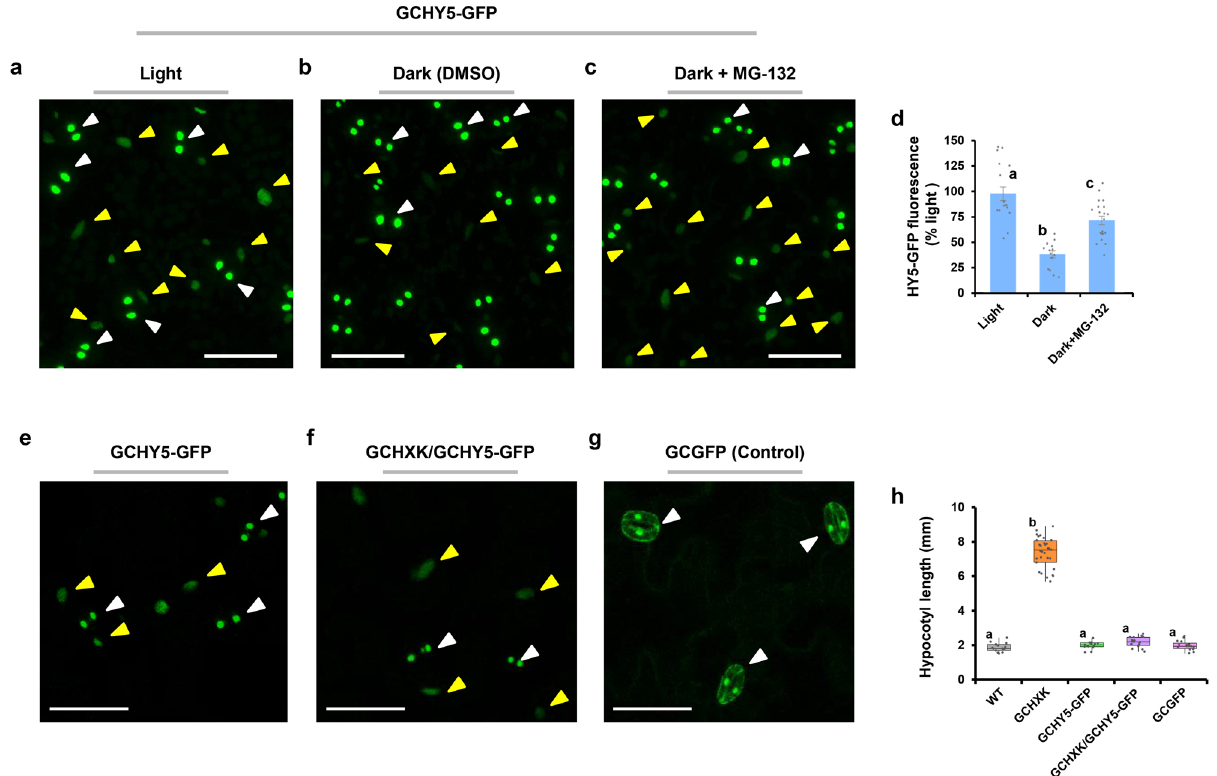
Fig. 8 Dark and GCHXK do not block the export of HY5 from guard cells. a – d HY5-GFP- fl uorescence intensity is light-dependent. Ten-day-old GCHY5- GFP seedlings treated with 15 µ M proteasome inhibitor; MG-132 c , kept in the dark for 16 h prior to image acquisition. b Dark-grown seedlings treated with 0.1% DMSO served as a control, and ( a ) light-grown seedlings served as an additional control. d Relative fl uorescence intensity of HY5-GFP. The fl uorescence intensity in the light was set to 100%. Data points are means ± SE ( n > 15). Light gray dots represent individual data points. Different letters indicate a signi fi cant difference (Tukey ’ s HSD test, P < 0.05). e – h GCHXK did not block the export of HY5 from guard cells. e – g Distribution of GFP signal in